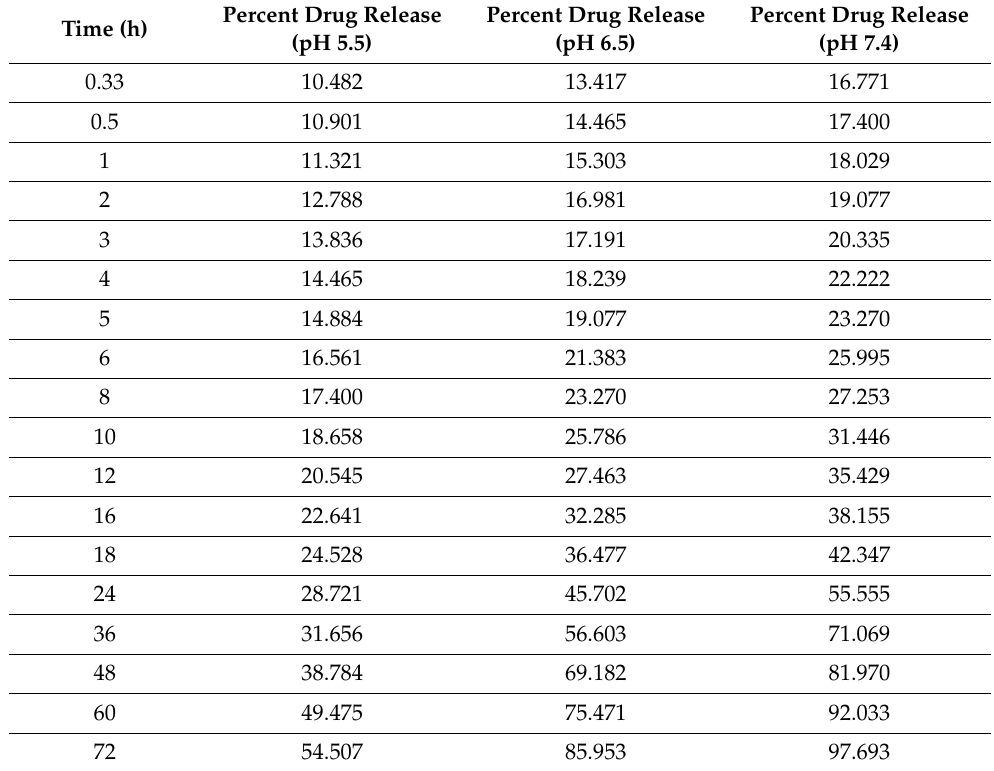
Table 3. Drug release of the optimized formulation